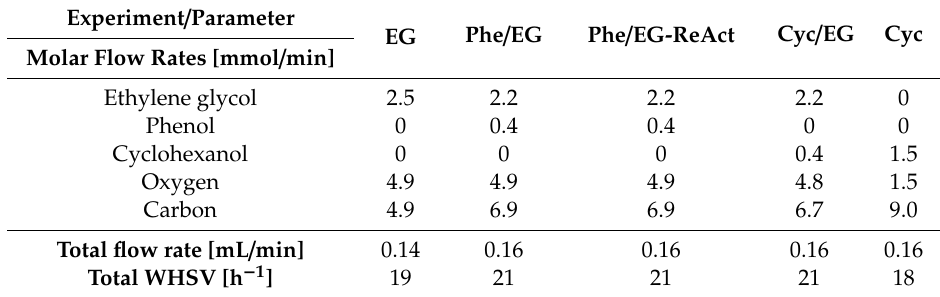
Table 6. Average model compound feed flow rates. Operating conditions: 27 bar H 2 , 550 vol ppm H 2 S, The total flow of N 2 , H 2 , and H 2 S was 69 mmol / min (1550 NmL / min). Experiment / Parameter EG Phe / EG Phe / EG-ReAct Ethylene